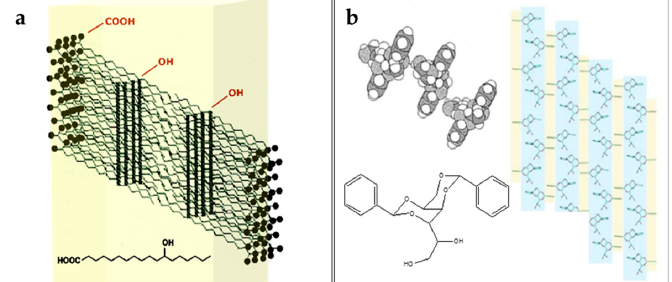
Figure 2. Chemical structure and representation of intermolecular interactions of: ( a ) HSA molecules; (b ) DBS molecules.